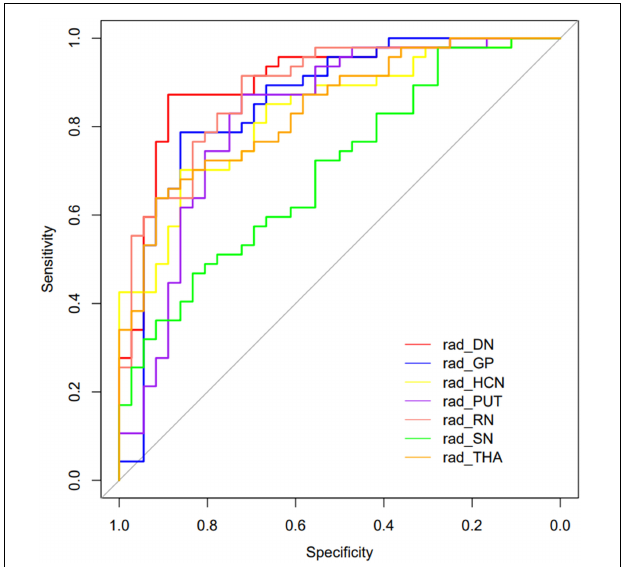
FIGURE 4 | The curves of the different model were shown. Different colors represented the model of different DGM regions.